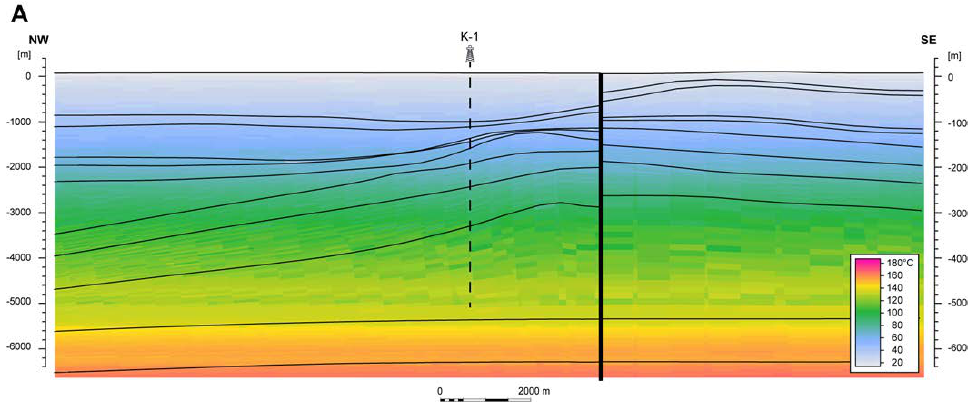
Figure 12. Distribution of the temperature along the NW–SE cross ‐ sections: ( A ) upper part, SMV1; ( B ) lower part, SMV2.